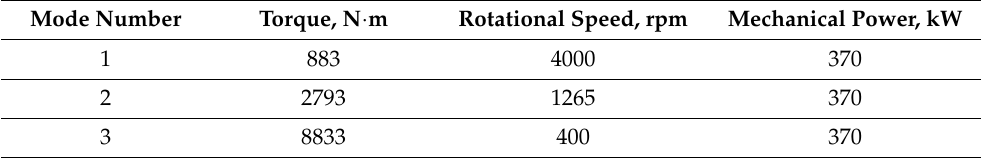
Table 1 indicates the motor operating points considered in the optimization procedure: maximum torque at rated speed, rated power at maximum speed, and an intermediate point with geometric mean values of the torque and speed. Table 1. Operating points of the SHM taken into account in the optimization procedure. Mode Number Torque, N · m Rotational Speed, rpm Mechanical Power, kW 1